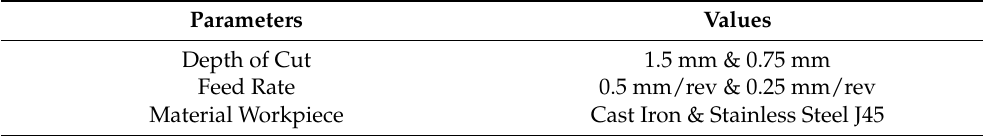
Table 1. Face milling cutting